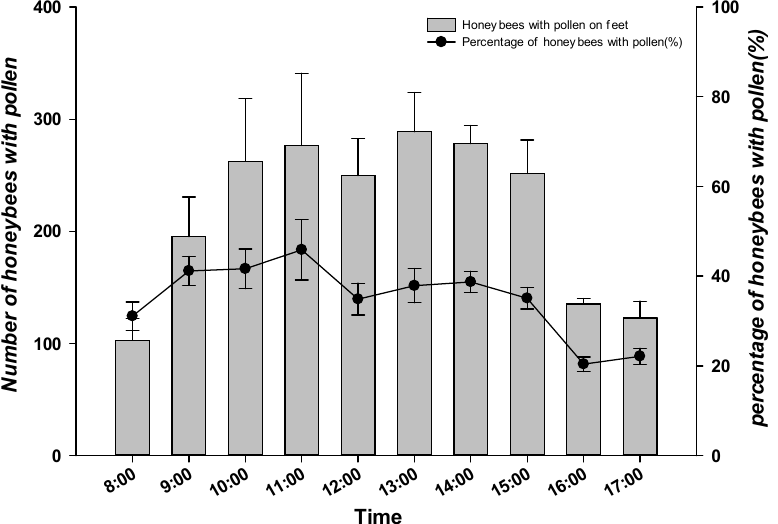
Figure 2. Proportion of pollinators. Numbers and percentages of honeybees that flew back to the hive with pollen on the corbiculae.